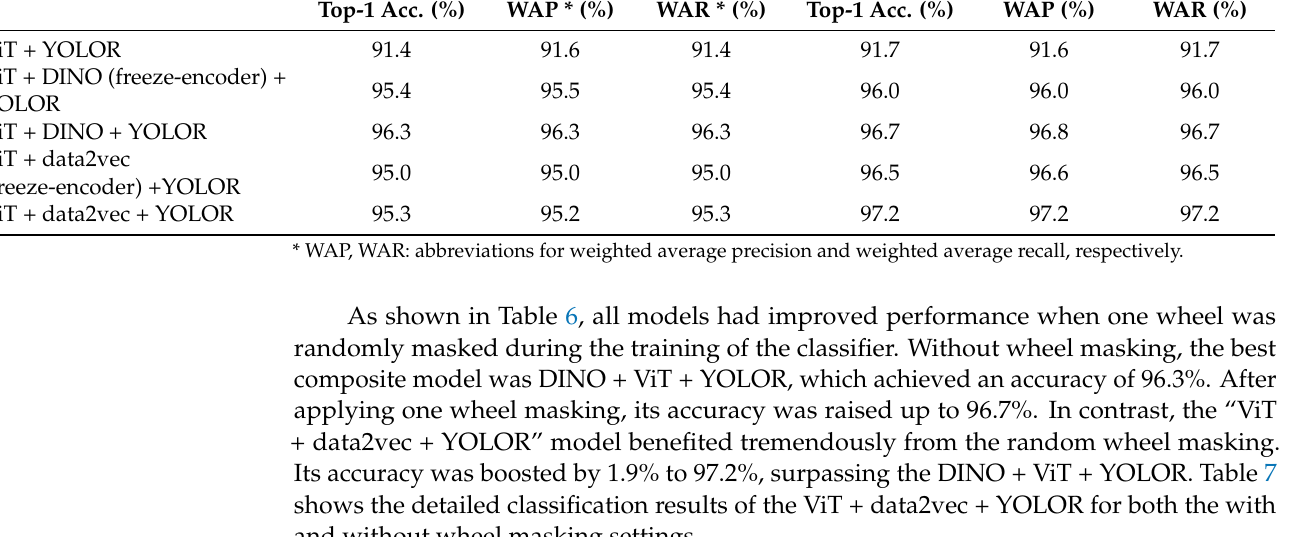
Table 6. Comparison of model performance with and without random wheel masking. Without Wheel Masking Randomly Masking One Wheel Network